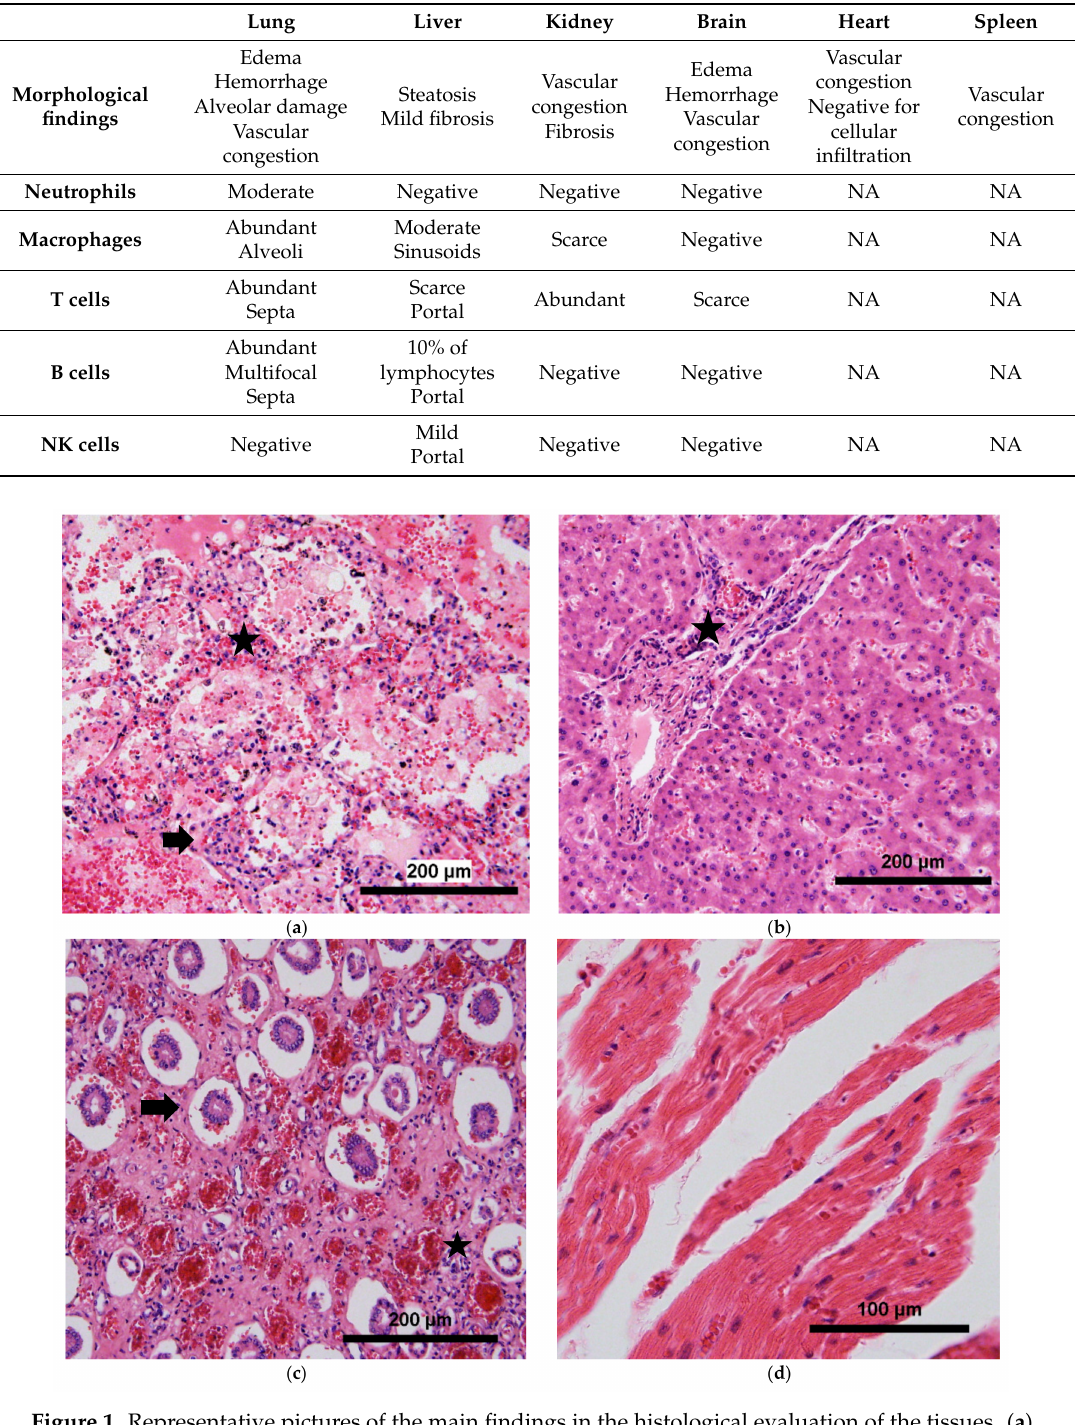
Figure 1. Representative pictures of the main findings in the histological evaluation of the tissues. ( a ) Lung tissue with alveolar septa damage and hemorrhage (star), associated with scarce inflammatory lymphocytic infiltrate in septa (arrow); ( b ) Liver tissue with moderate inflammatory infiltrate in portal triad (star) and sinusoidal edema; ( c ) Kidney tissue with vascular congestion (arrow), atrophy and tubular necrosis, associated with moderate inflammatory infiltrate (star) and signs of stromal fibrosis; ( d ) Heart tissue with interstitial edema and vascular